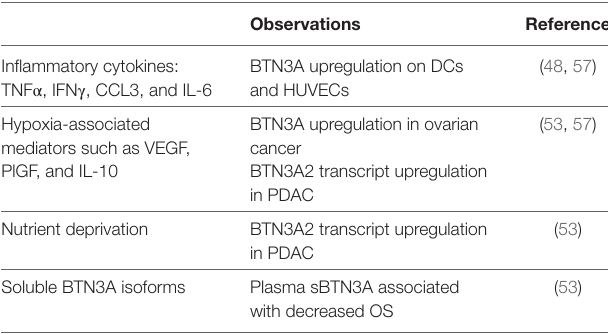
TABLe 3 | Factors driving BTN3A regulation in the tumor